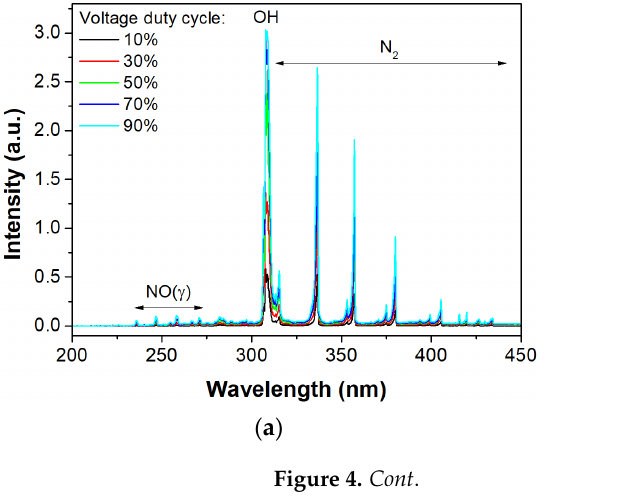
( b ) Figure 2. Power density values of the funnel reactor: ( a ) while varying the applied voltage with